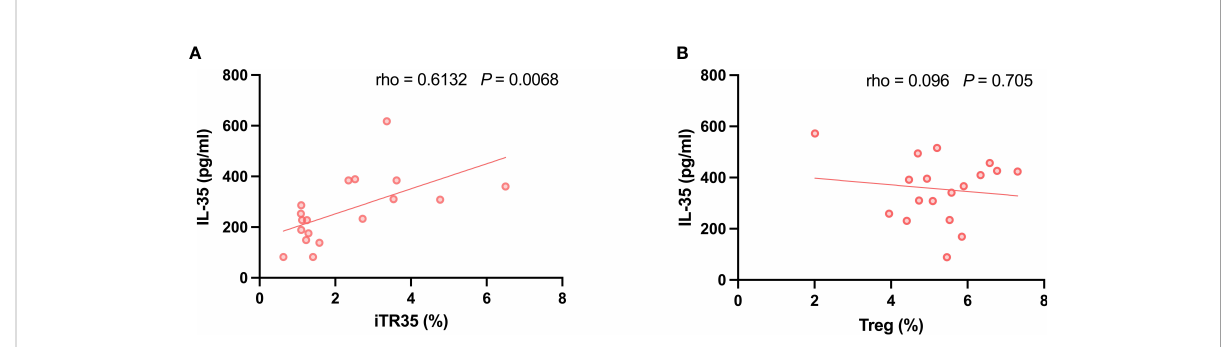
FIGURE 7 Correlation analysis of Treg 、 iTR35 cells and IL-35. (A) The positive correlation between iTR35 cells frequency and IL-35 was expressed by Spearman rank correlation analysis. (B) There is no signi fi cant correlation between Treg cells frequency and